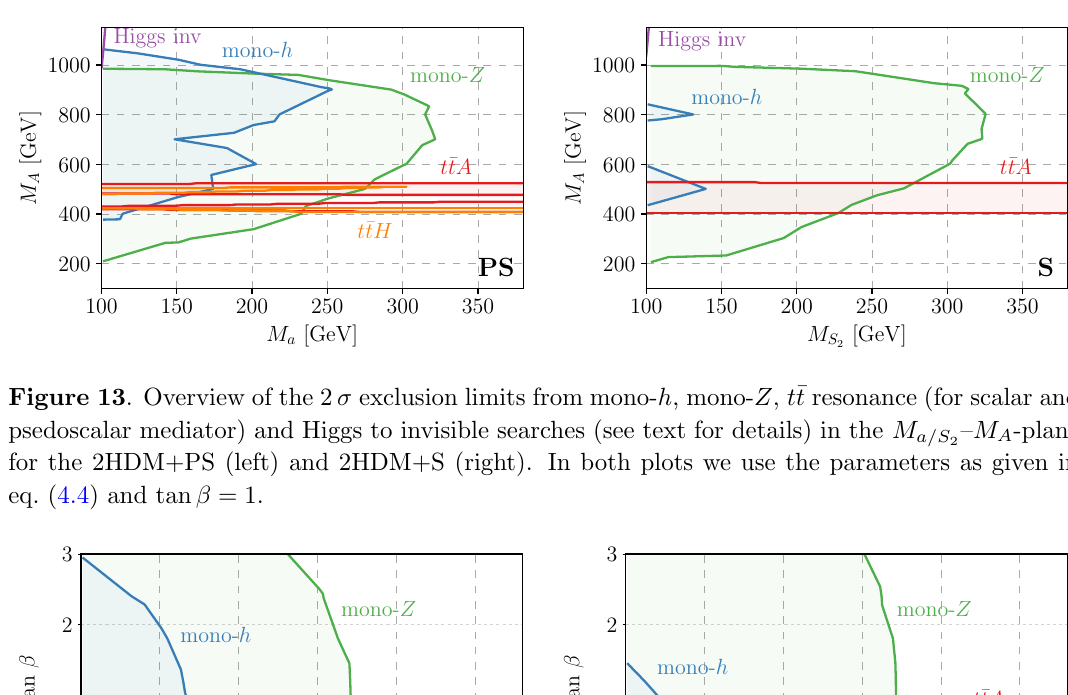
{tan (cid:12) - a=S 2